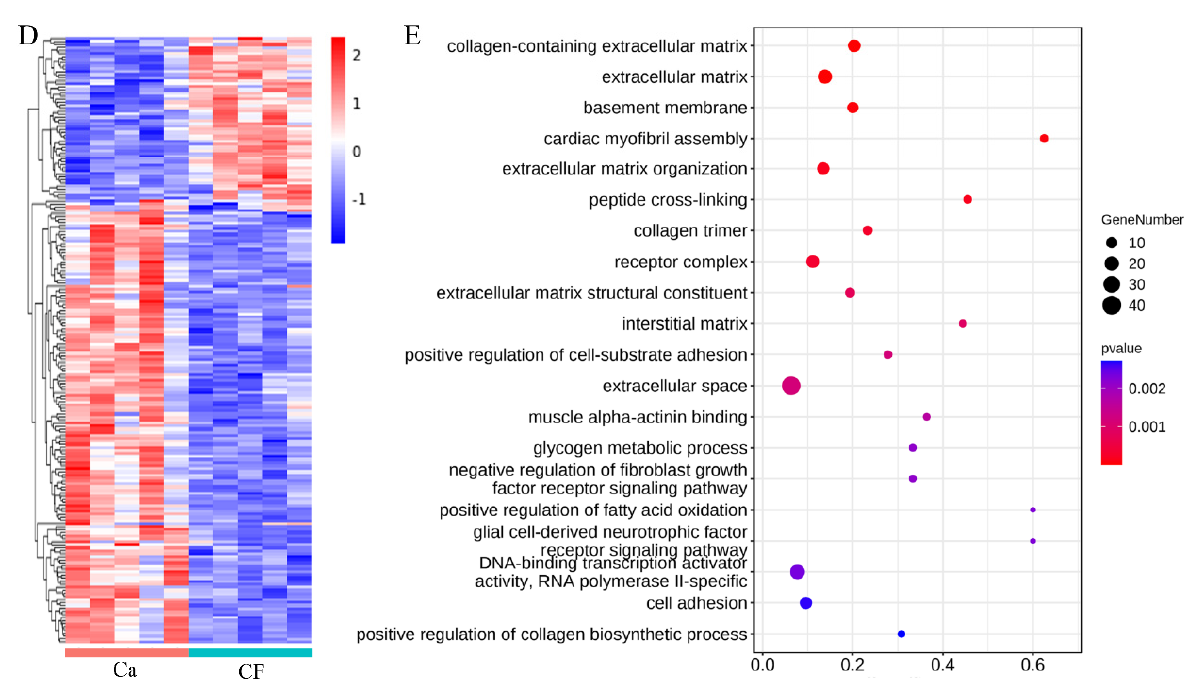
Figure 2. Transcriptome analysis of leg muscle samples from cage-free and caged groups. “Ca” refers to the caged rearing group, and “CF” refers to the cage-free group. ( A ) Pearson correlation analysis between samples. “CF” refers to the cage-free group, and “Ca” refers to the cage-rearing group. Numbers refer to correlation coefficient between samples. ( B ) Volcano plot of differentially expressed genes. The X-axis refers to the log2-fold fold change, and the Y-axis refers to − log10 ( p value). The red dots and green dots represent the upregulated and downregulated genes, respectively. ( C ) qPCR verification of RNA-seq results. All 5 genes ( COL3A1 , FBN1 , FABP3 , GLS2 , and NR4A3 ) followed a similar RNA-seq expression pattern. The X-axis represents different developmental groups, and the Y-axis represents the relative expression levels. “*” and “**” refer to significant differences with p values < 0.05 and < 0.01, respectively. Error bars indicate standard errors. ( D ) Heatmap of the top 200 DEGs. Different colors refer to different expression levels. ( E ) The top 20 enriched GO terms of DEGs. The X-axis refers to the rich factor. The Y axis refers to different GO